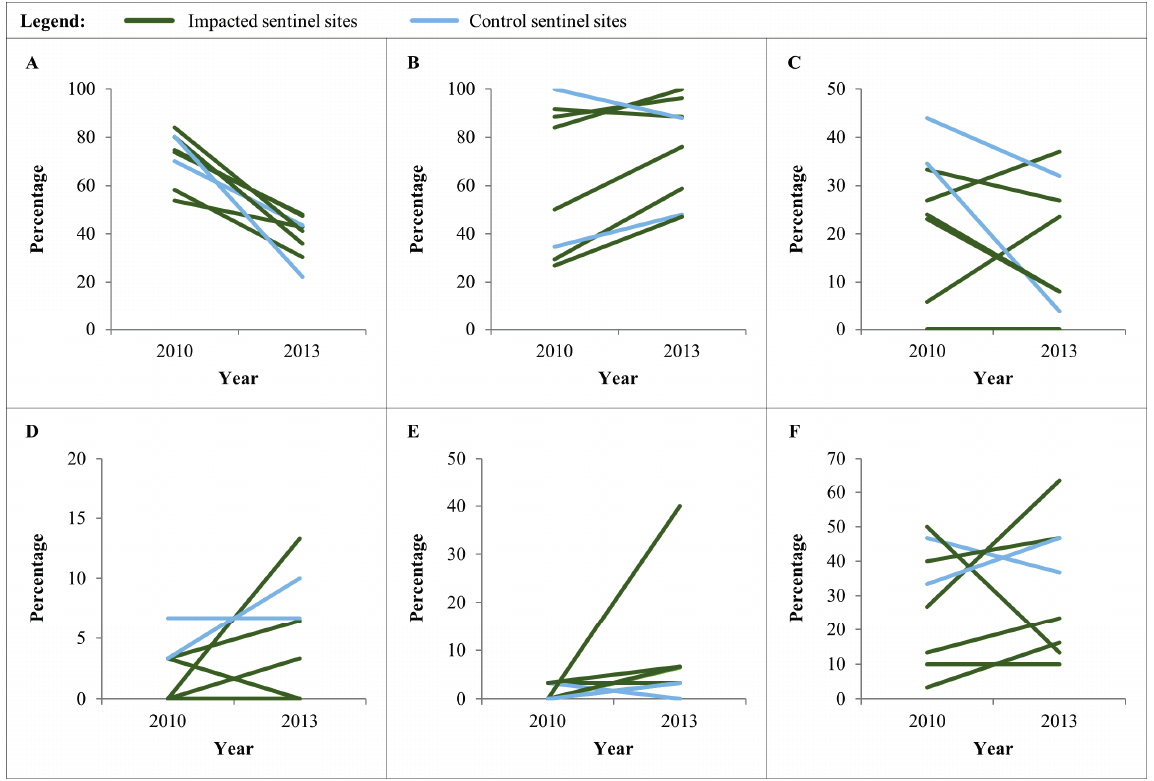
Figure 5. Indicators in women of reproductive age (15–49 years) and school-going children aged 10–15 years in the ABSL study area, stratified by sentinel site, 2010 and